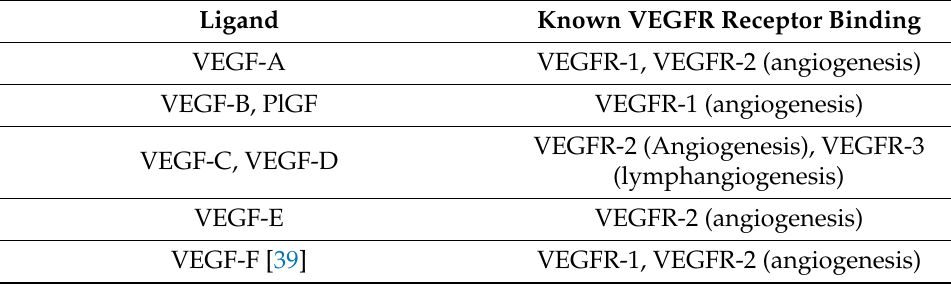
Table 2. VEGF ligands and their receptor binding